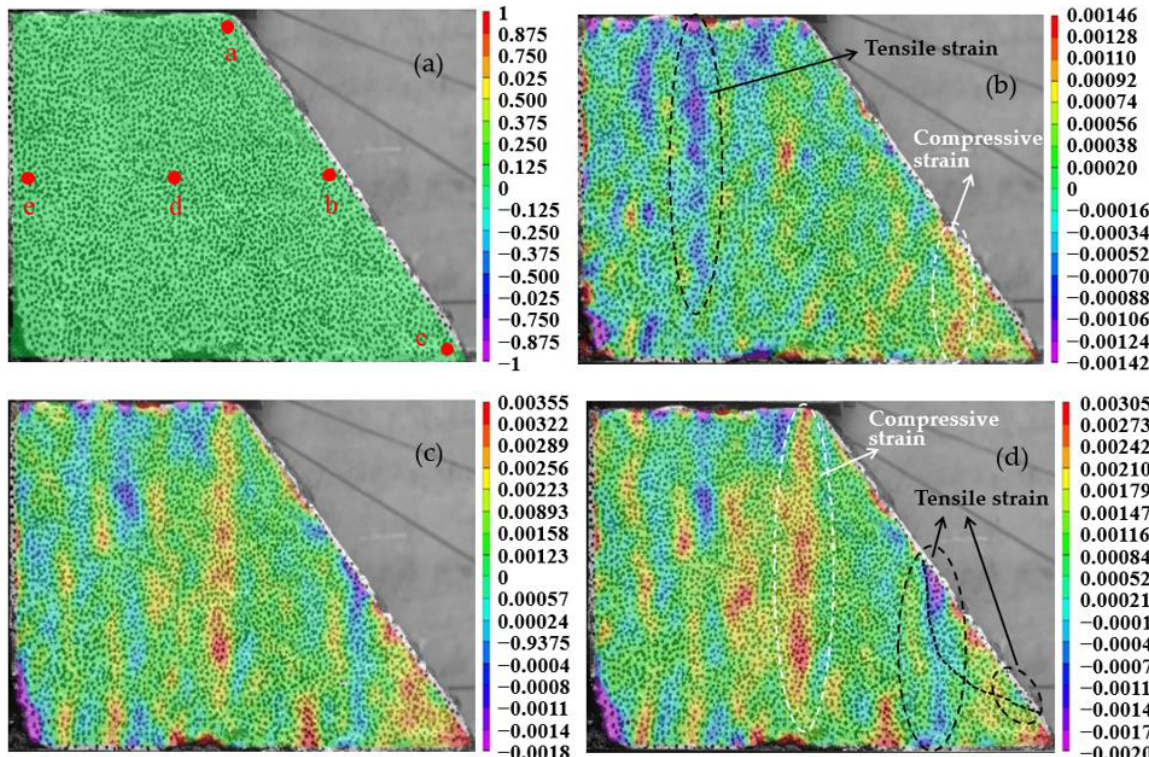
Figure 5. Strain contours of the slope model with no crack under different loadings. ( a ) No loading; ( b ) under 1.6 MPa; ( c ) under 3.2 MPa; ( d ) under 16 MPa.